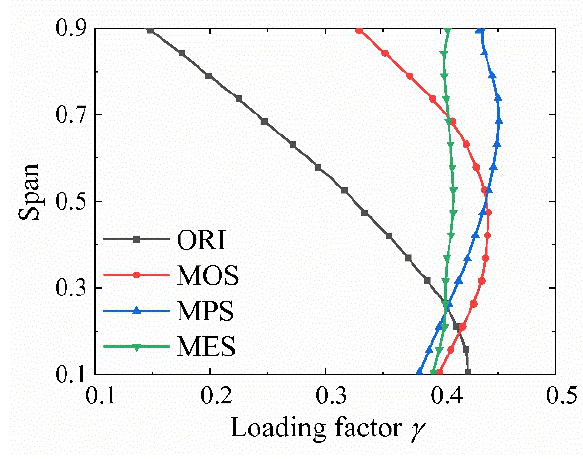
Figure 16. Load factor distribution along the spanwise direction.